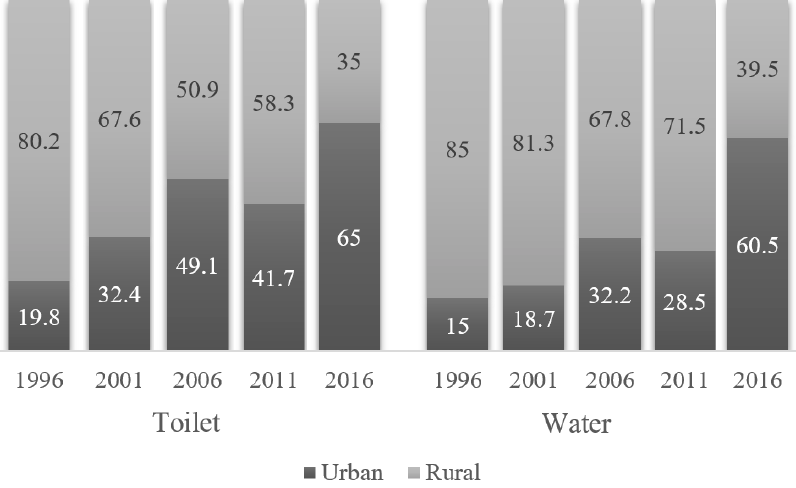
Figure 7. Trend in inequality in improved water and sanitation coverage between urban and rural areas.